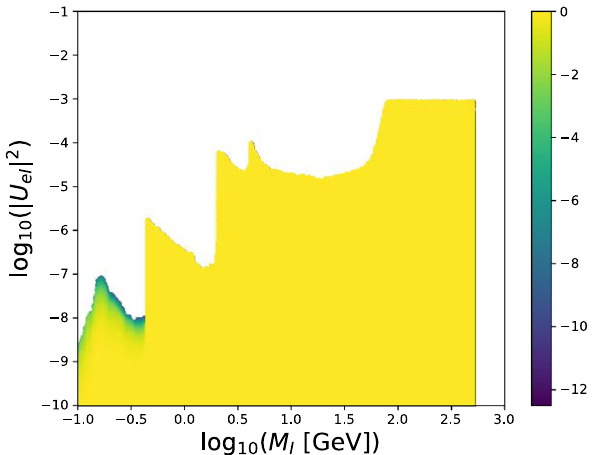
Fig. 19 Partial likelihood from direct searches with PS191, e -channel, in the M I − | U eI | 2 plane